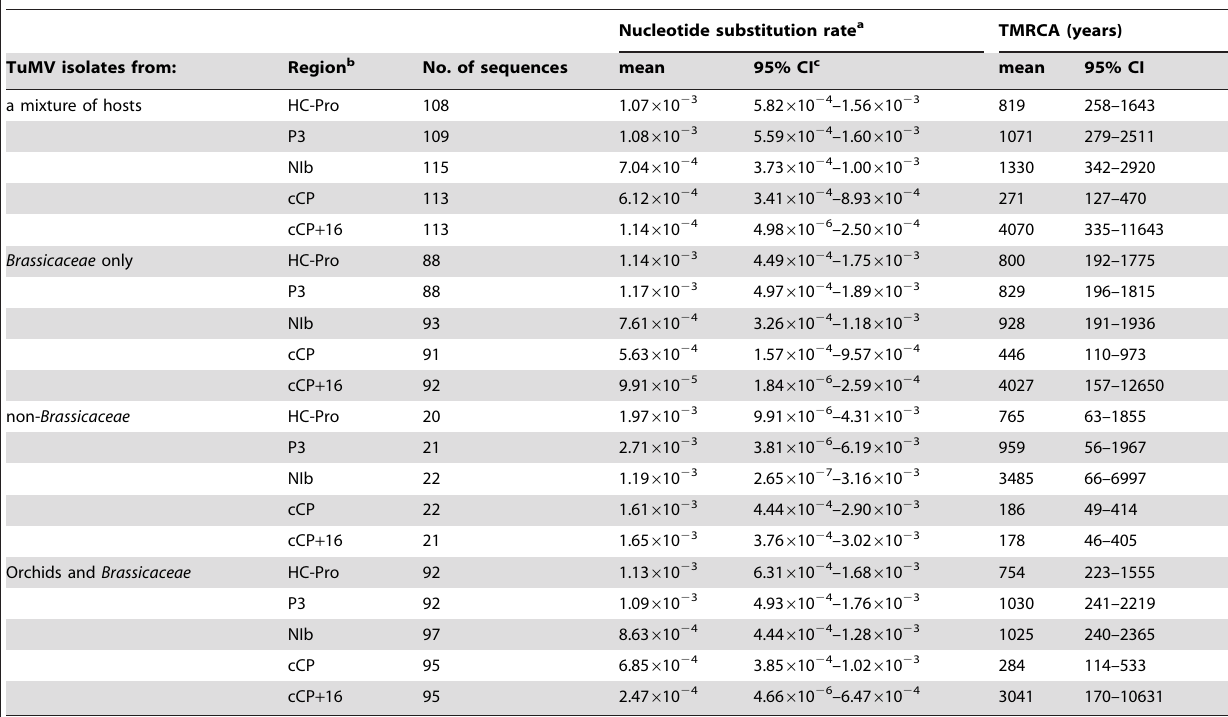
Table 3. Estimates of the substitution rates and times to the most recent common ancestor (TMRCA) for TuMVs isolated from various hosts, from only Brassicaceae or from non- Brassicaceae , or from orchids and Brassicaceae .